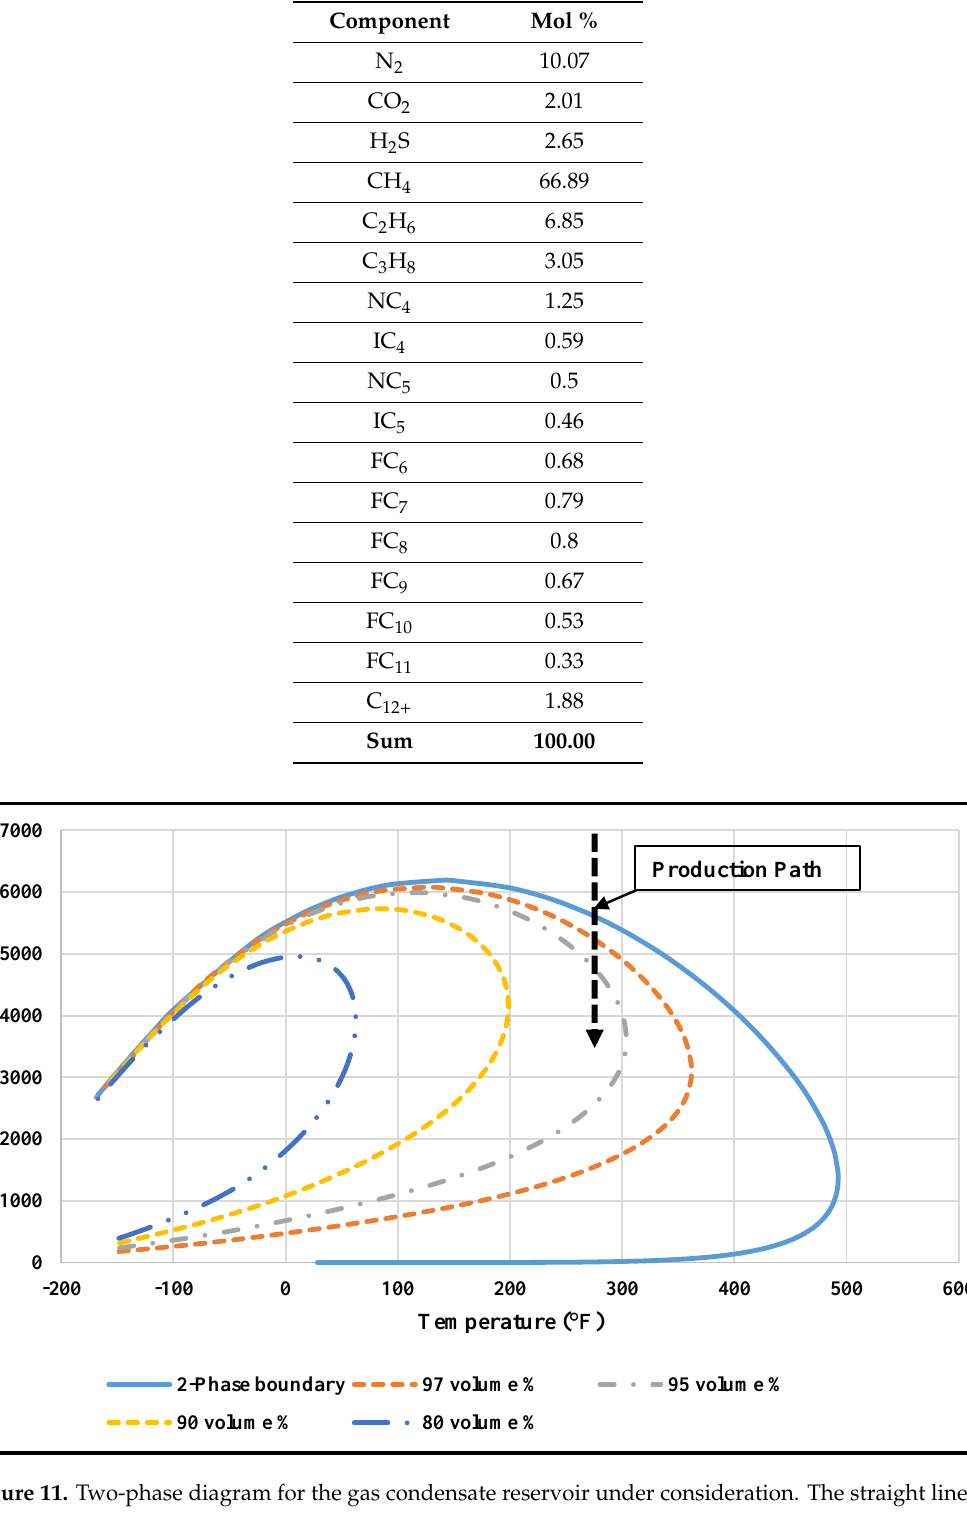
Figure 12. Simulation results and experiment measurements for constant-composition expansion.